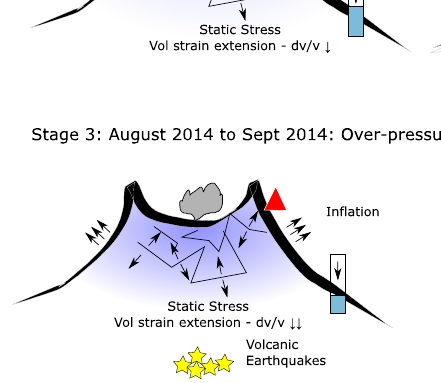
Fig. 5 | Conceptual model. Conceptual model for the precursory activity prior to the2014eruptionatMtOntake(nottoscale).Wede fi ne3stagescorrespondingto Stage 1: sealing of the sub-surface/Stage 2: pressurization/Stage 3: Over- pressurization. The red triangle corresponds to seismic stations located on the